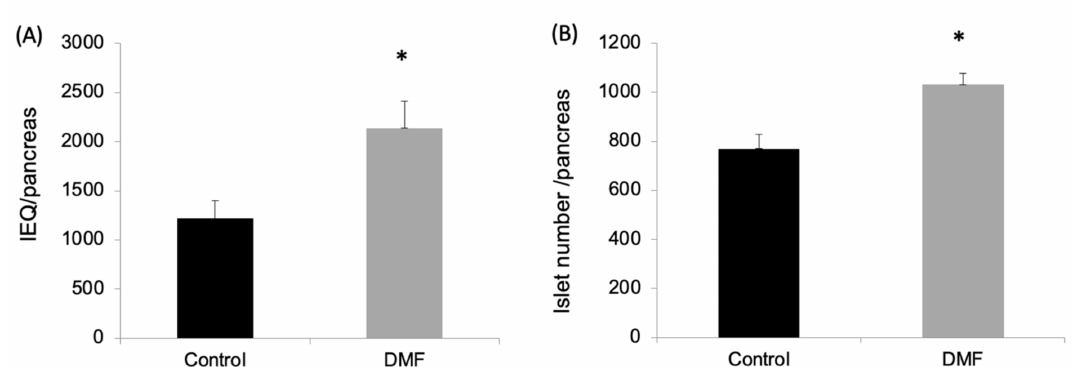
Figure 1. Dimethyl fumarate (DMF) treatment improved islet yield from the rats’ pancreases. After islet isolation, the islet yields (both islet equivalents (IEQ) ( A ) and islet number ( B )) from the rat pancreases were significantly higher in the DMF-treated group than the control group (* p < 0.05, respectively).